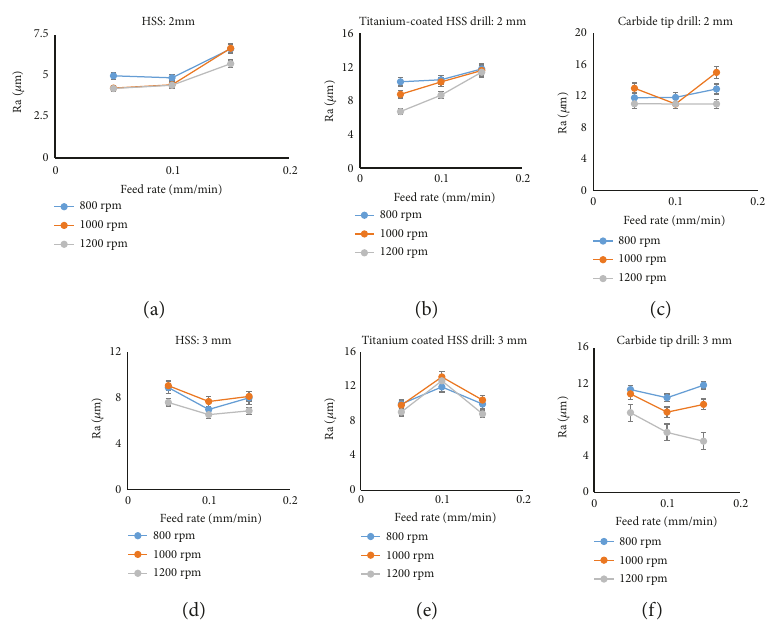
Figure 8: Surface roughness for 2 and 3 mm thickness specimens under three di ff erent drills. (a – c) Surface roughness of the 2 mm sample with (a) HSS drill, (b) titanium-coated HSS drill, and (c) carbide tip drill. (d – f) Surface roughness of the 3 mm sample with (d) HSS drill, (e) titanium-coated HSS drill, and (f) carbide tip drill. Table 2: Di ff erent control parameters and their levels. Control